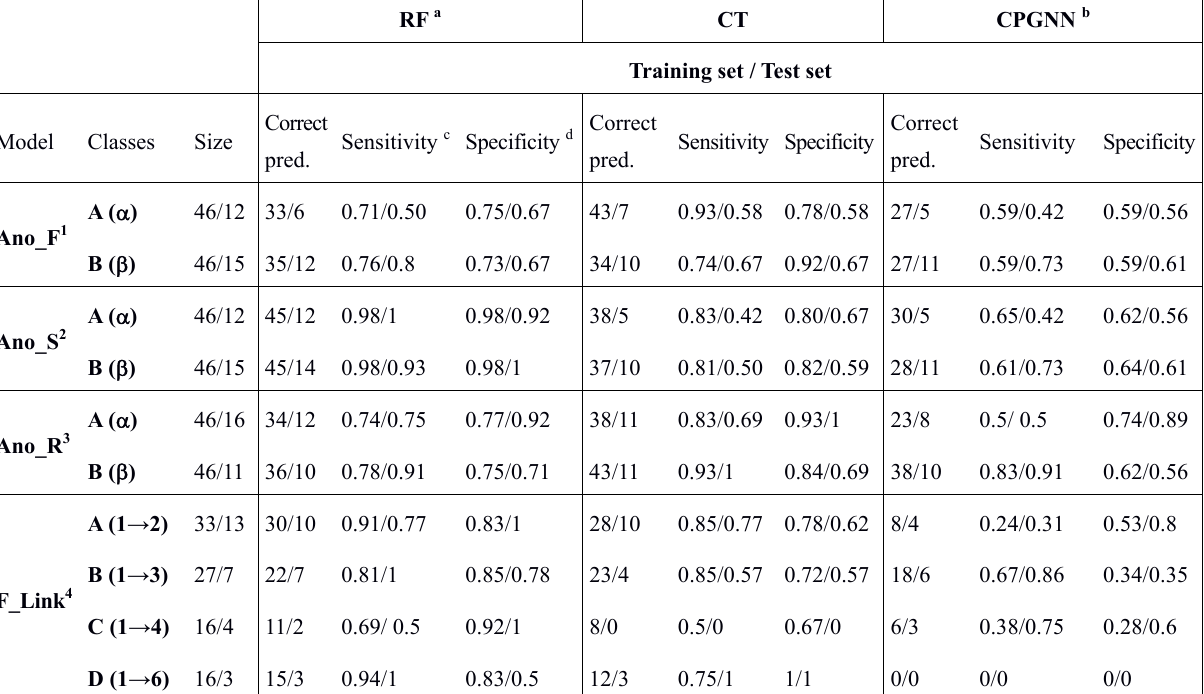
Table 1. RF, CT and CPGNN predictions of the anomeric configurations, type of linkages, residues and chain type in trisaccharides from 1D 13 C-NMR